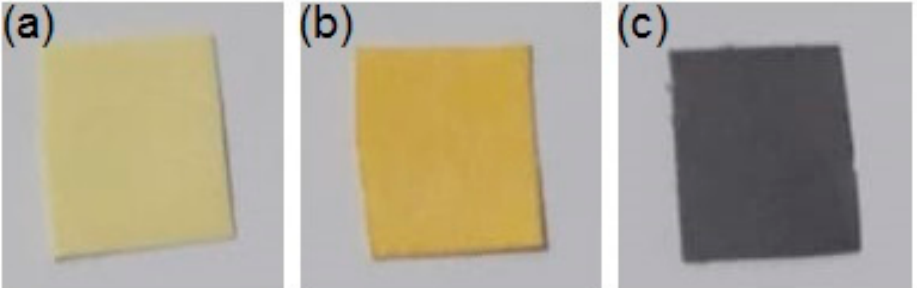
Figure 5. Photographs of test strips after exposure to different concentrations of cadmium ions in an aqueous medium, illustrating color change between yellow (( a ); 0 ppm), orange (( b ); 10 ppm), and red (( c ); 250 ppm).